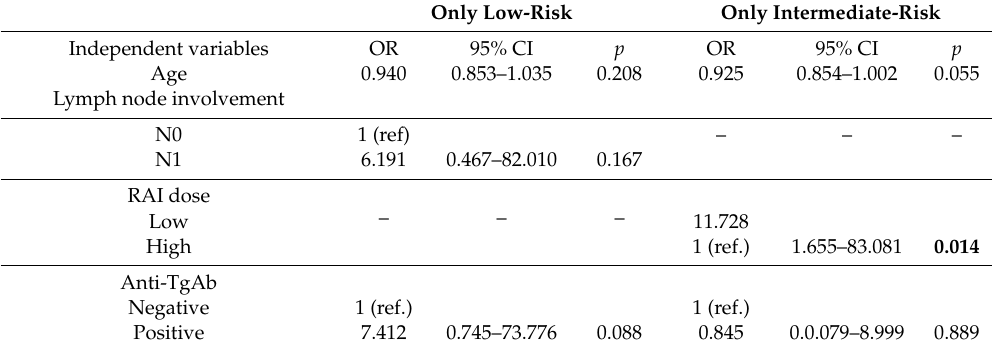
Table 5. Multivariate Logistic Regression Analysis—odds of recurrence (separate analysis based on initial risk of